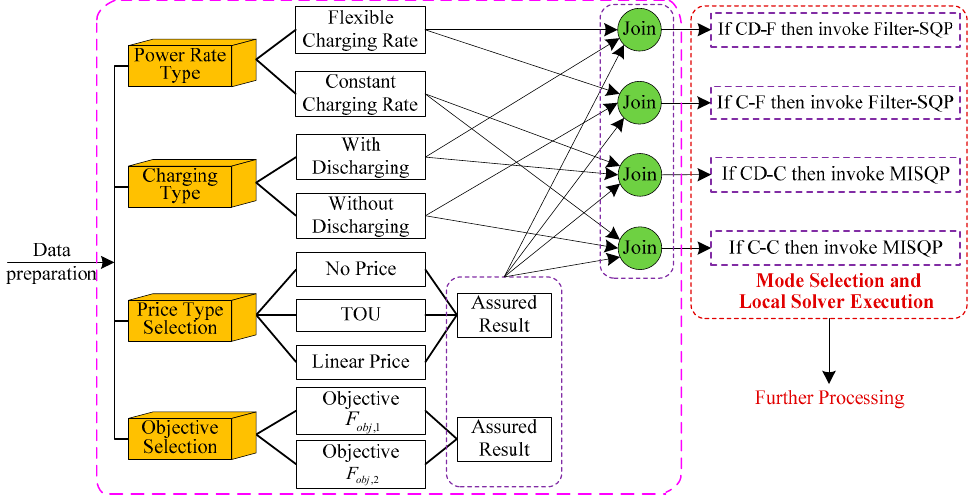
Figure 3. The intelligent module for executing the local solvers of the intelligent scatter search (ISS).